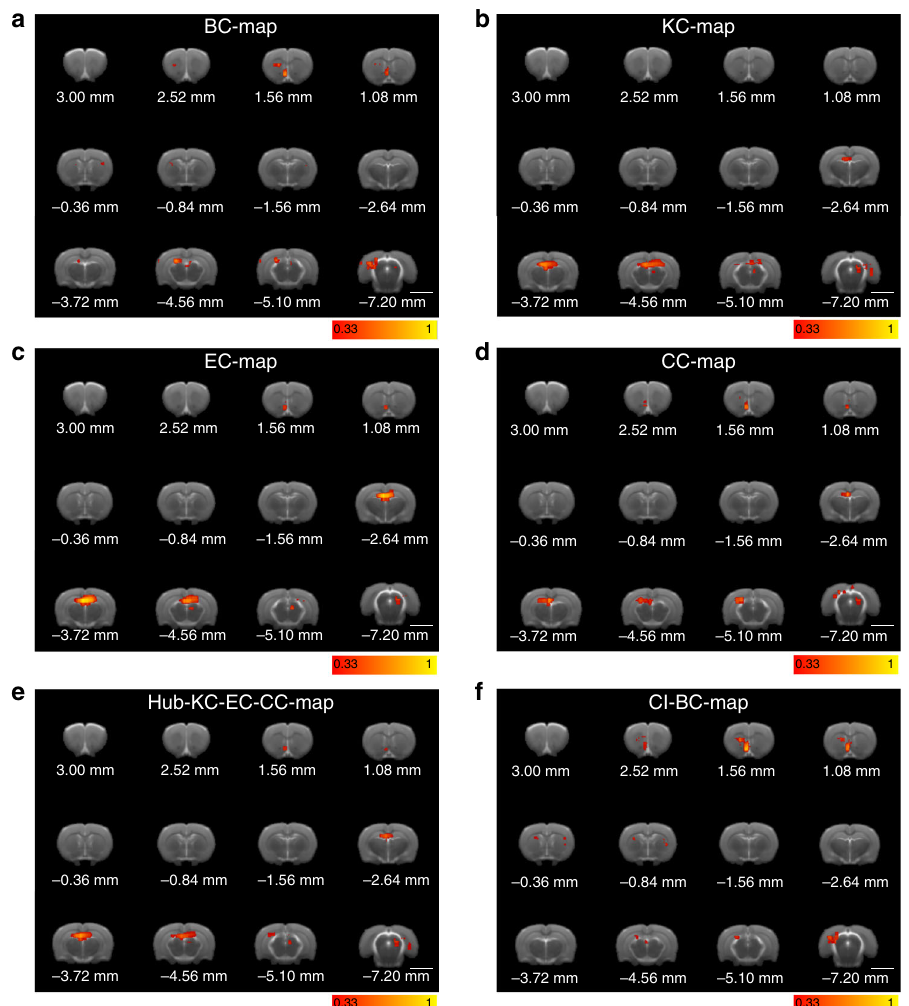
Fig. 3 Maps of essential nodes. Average map of in fl uencers for the different centralities according to a betweenness centrality, b k -core centrality, c eigenvector centrality, and d closeness centrality. The maps are averaged over the six rats and the color bars are calculated according to the rank de fi ned by Supplementary Note 4, Eq. (8). Yellow/white colors indicate the top in fl uencers according to each centrality. According to these results, the centralities are then divided into e hub-centric centralities dominated by the hubs and identifying the hubs in the HC and f integrative centralities dominated by the weak nodes and identifying the low-degree nodes in the shell part of the NAc. The size bar in each panel corresponds to 0.5